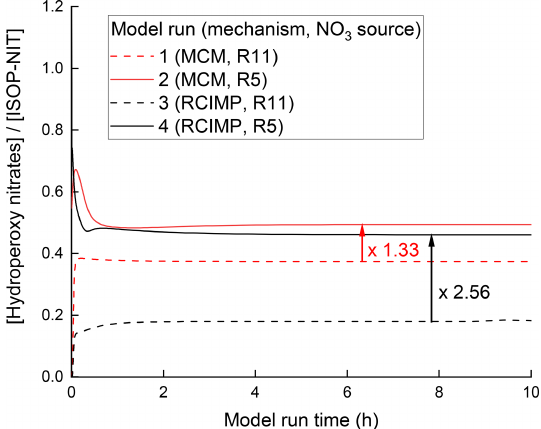
Figure 10. Simulated fractional contribution of hydroperoxy ni- trates to ISOP-NIT using schemes taken from the MCM (red) and from RCIMP (black). The simulations reproduce the experimen- tal conditions in Figs. 3 and 6, with 22ppbv of isoprene together with either 3ppbv N 2 O 5 as NO 3 source (runs 1 and 3) or 10.8ppbv NO 2 + 150ppbv O 3 (runs 2 and